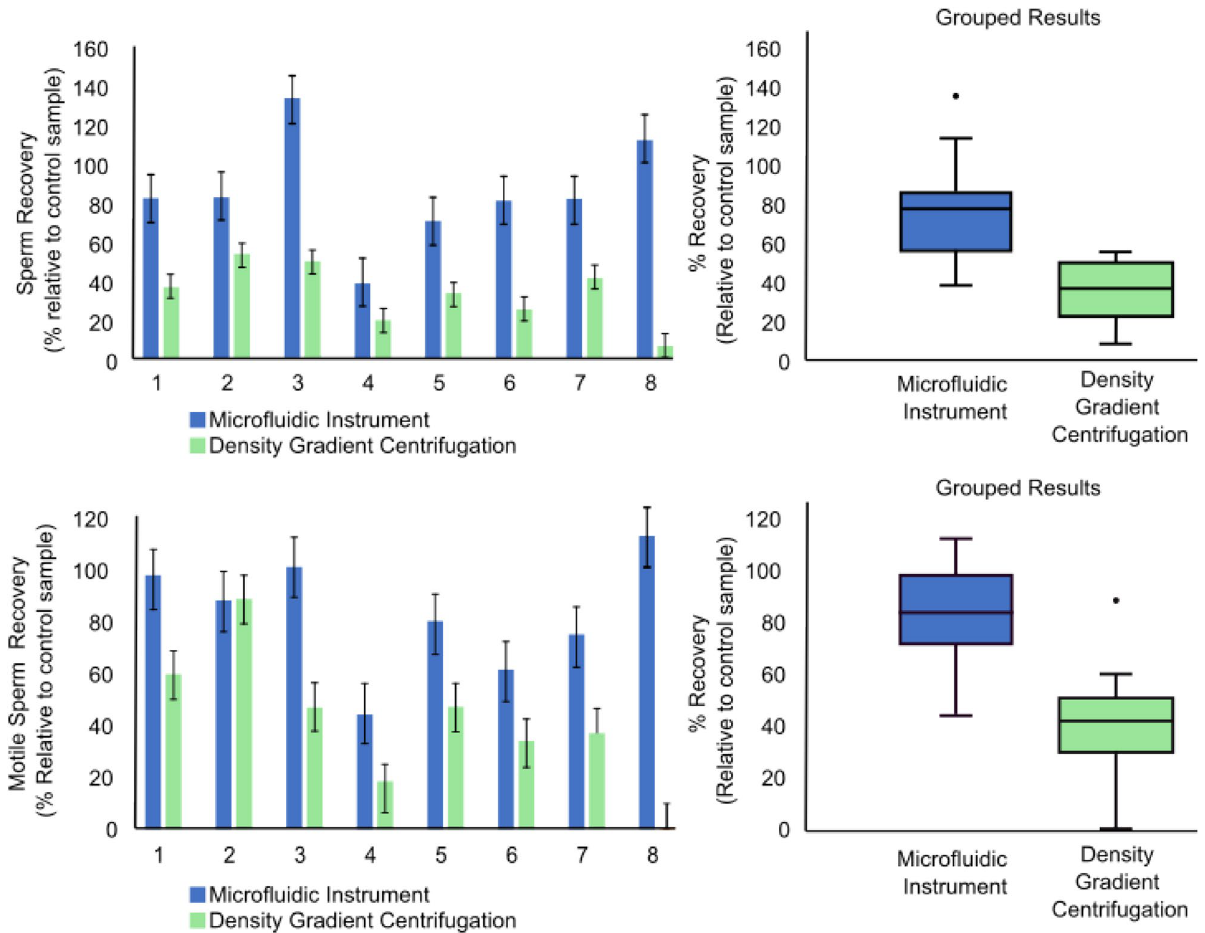
Figure 5. Sperm cell recovery from samples from eight males processed with the microfluidic instrument and through density gradient centrifugation. Results for all sperm cells (above) as well as motile sperm cells (below) are reported. Percentages are reported relative to the number of cells in a control sample that received no processing. Error bars, equal to 10% of the value of the highest count, represent the errors in counting. Box plots at right represent the compilation of the eight males and are offer an additional way to visualize the same data.